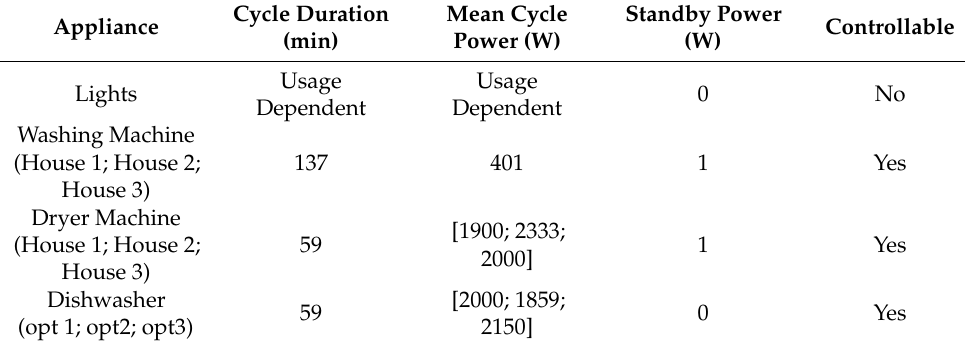
Table 3. Electrical appliance considered for this work.